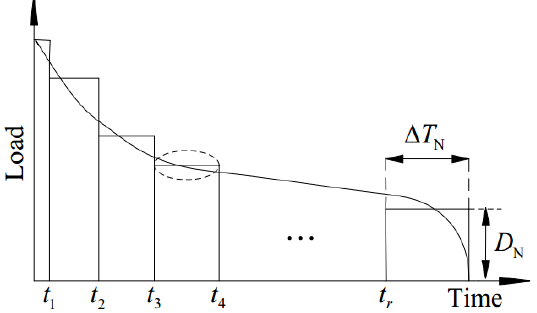
Figure 1. Load-block representation of the yearly load